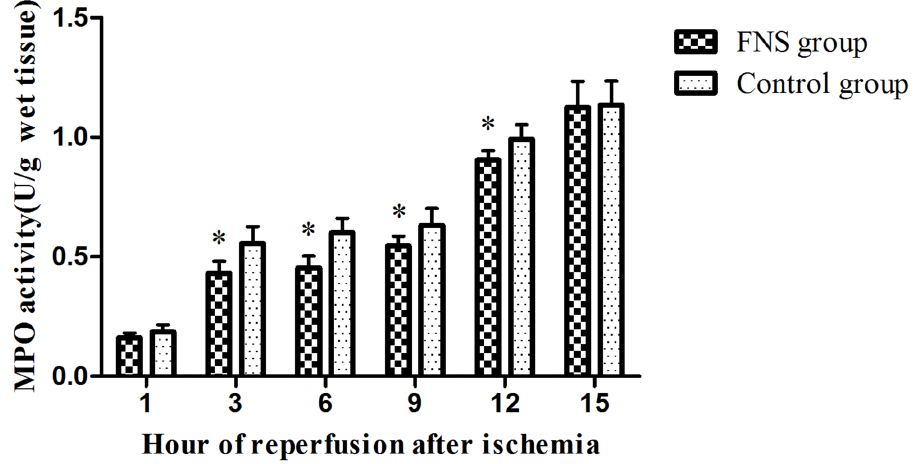
Fig 5. The MPO activity was detected using a spectrophotometer in cerebral ischemic penumbra. Results are expressed as the mean ± SD. * p < 0.05, vs the control group, n =